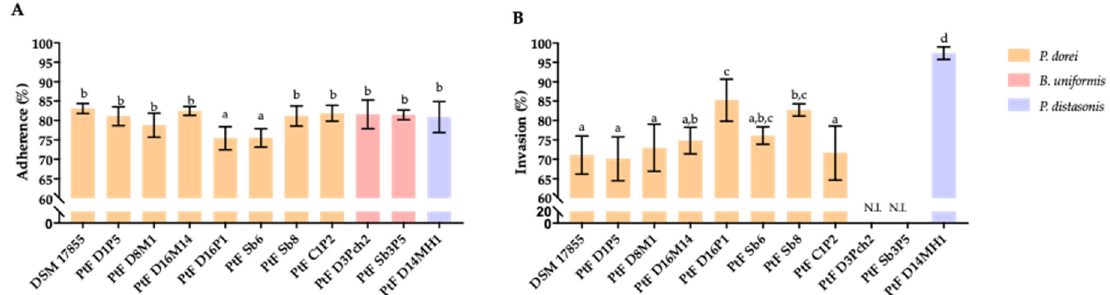
Figure 3. ( A ) Adherence and ( B ) invasion ability (%) of the Bacteroides species tested with HT29-MTX-E12 cell line. Bars with the same lowercase letter are not statistically different ( p > 0.05). N.I.—non-invasion.